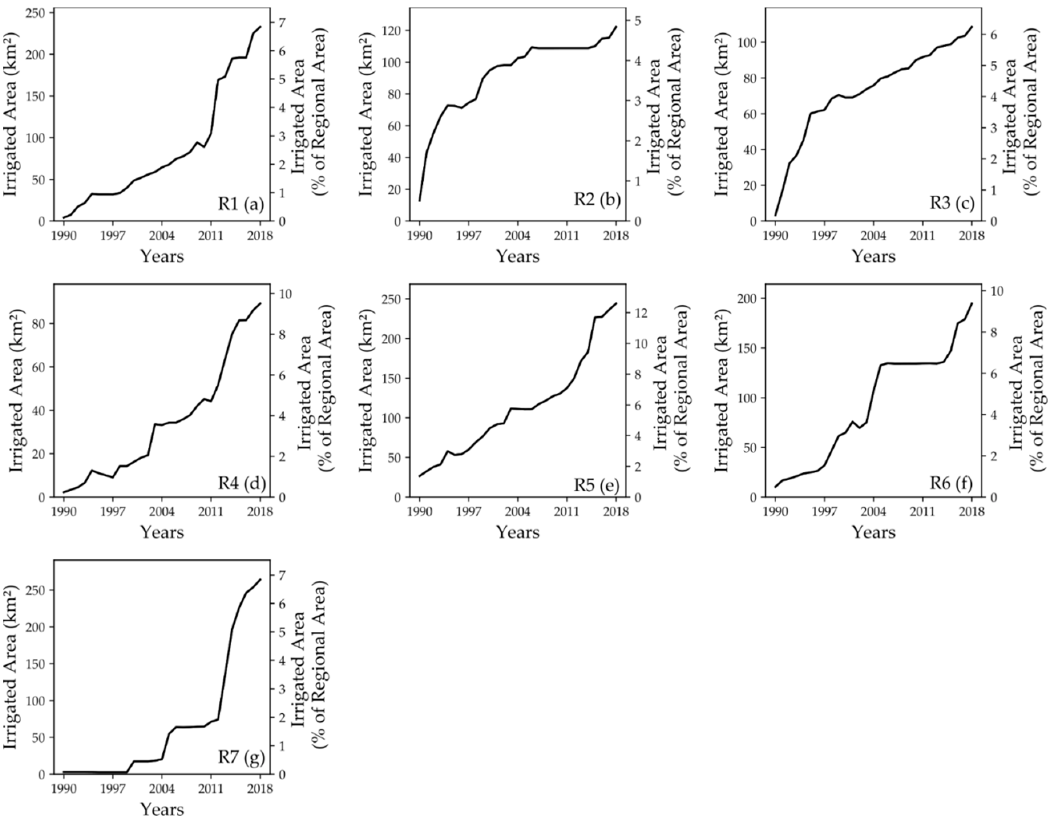
Figure 10. Evolution of irrigated area in selected regions, as defined in Figure 9 and Table 2.